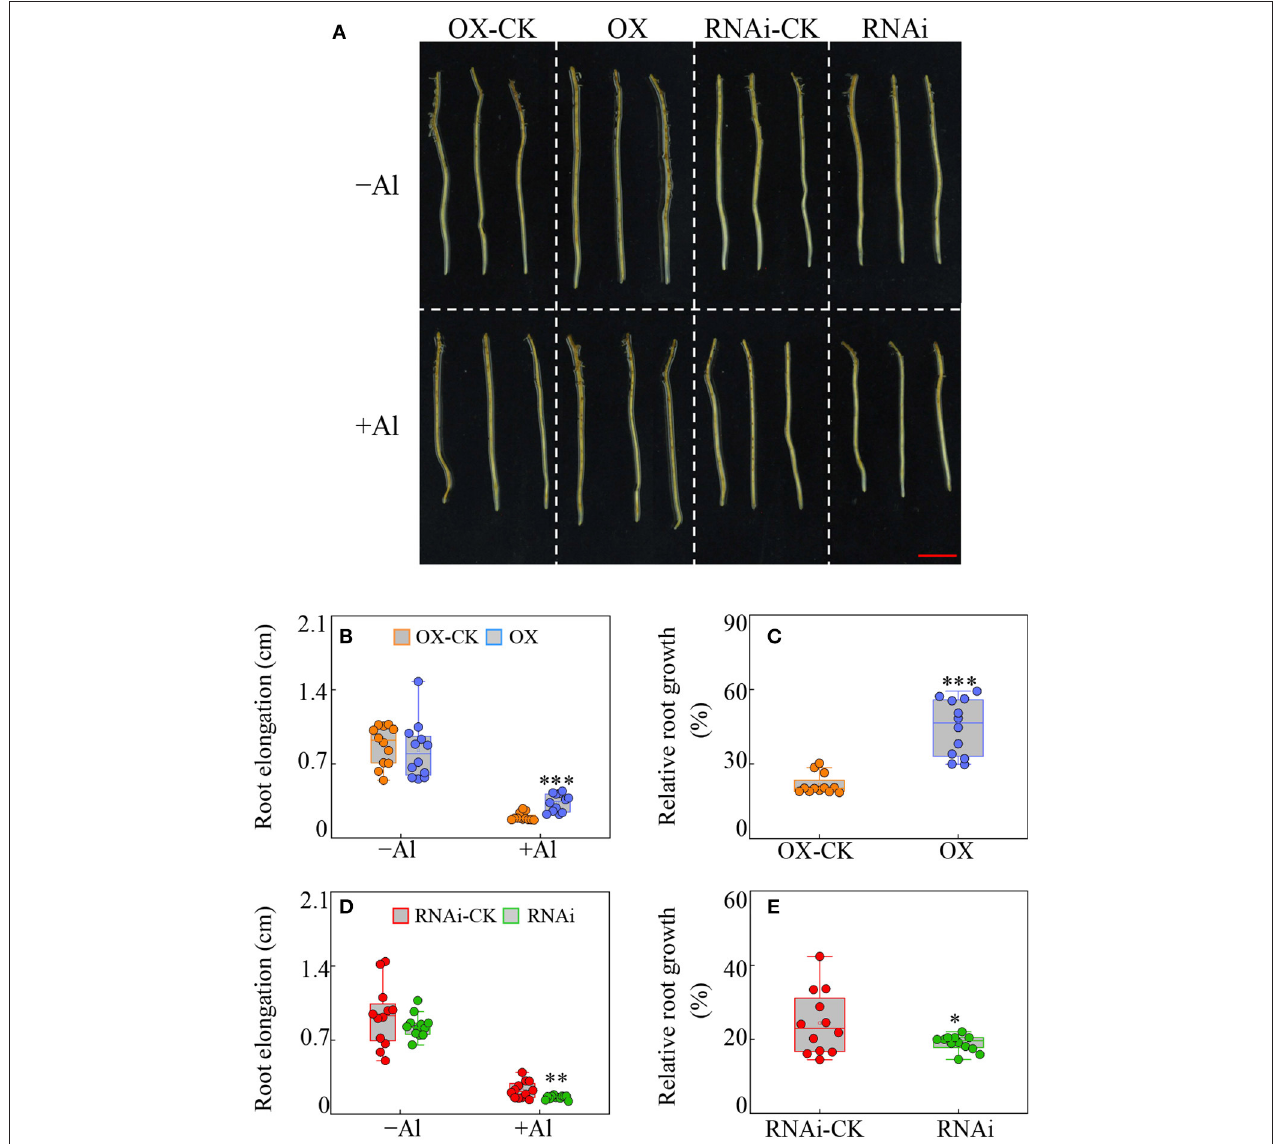
FIGURE 3 | Effects of GmBBE-like43 overexpression (OX) and RNA-interference (RNAi) on transgenic soybean hairy roots in response to Al treatment. (A) Phenotypes of transgenic soybean hairy roots in response to Al stress. (B–E) Root elongation (B,D) and relative root elongation (C,E) of soybean hairy roots with either GmBBE-like43 overexpressing (B,C) or GmBBE-like43 RNA-interference (D,E) . For Al treatment, the uniform soybean hairy roots were transferred to 1/4 modified liquid MS medium (pH 4.2, without KH 2 PO 4 ) with either 0 µ M (–Al) or 100 µ M ( + Al) AlCl 3 for 24h. Asterisks indicate significant difference between transgenic hairy roots with either GmBBE-like43 overexpressing or RNA-interference and their corresponding empty vector controls according to Student’s t -test: * : P < 0.05; ** : 0.001 < P < 0.01; *** : P <